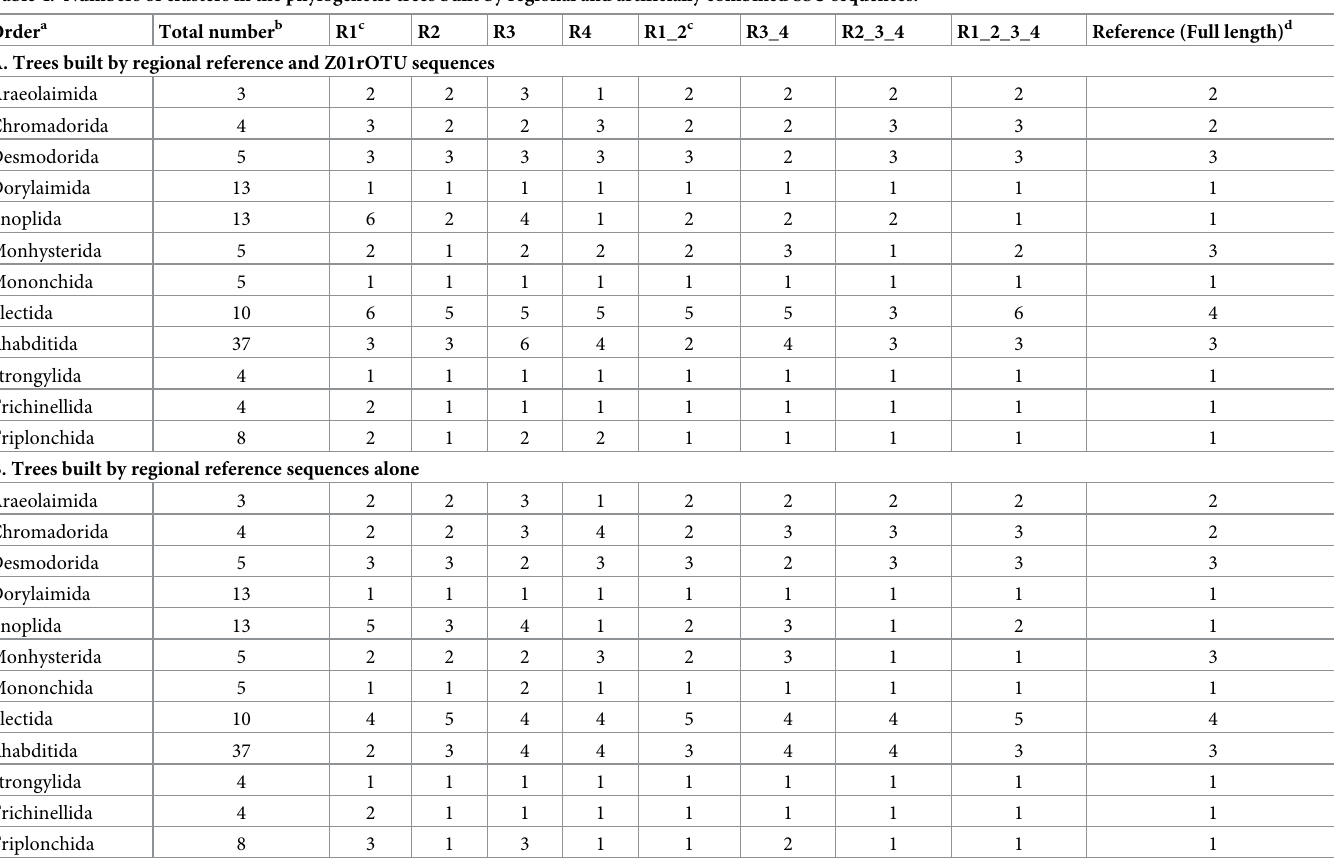
Table 4. Numbers of clusters in the phylogenetic trees built by regional and artificially combined SSU